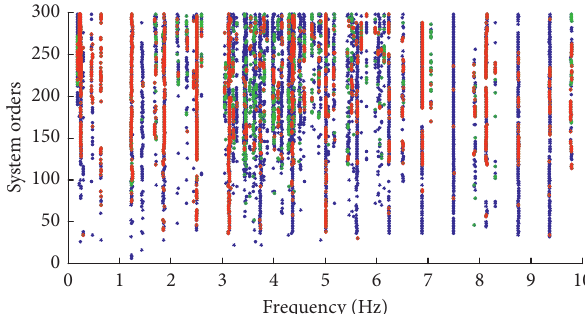
Figure 17: Stability diagram of EEMD.